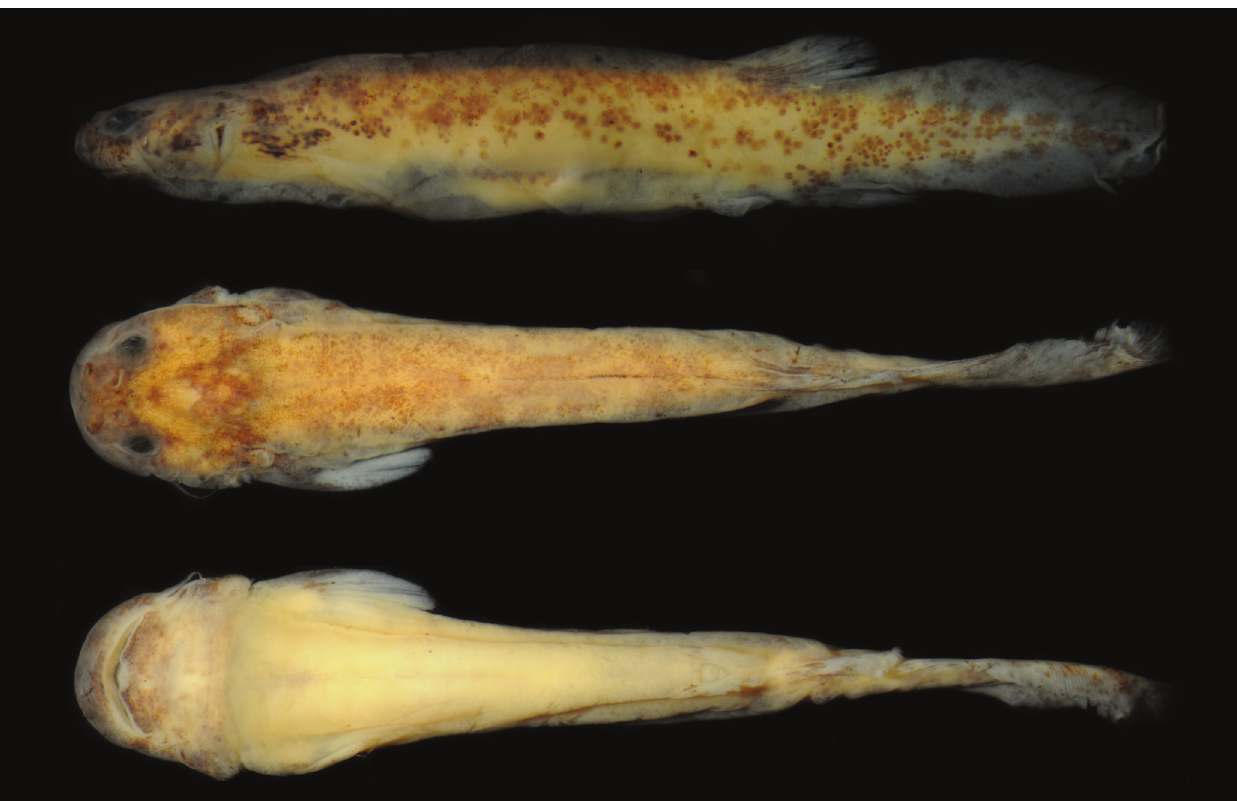
Fig. 2. Ochmacanthus batrachostoma , MZUSP 59340 (25.25 mm SL), Brazil, Mato Grosso do Sul, Corumbá, dead arm of Abobral